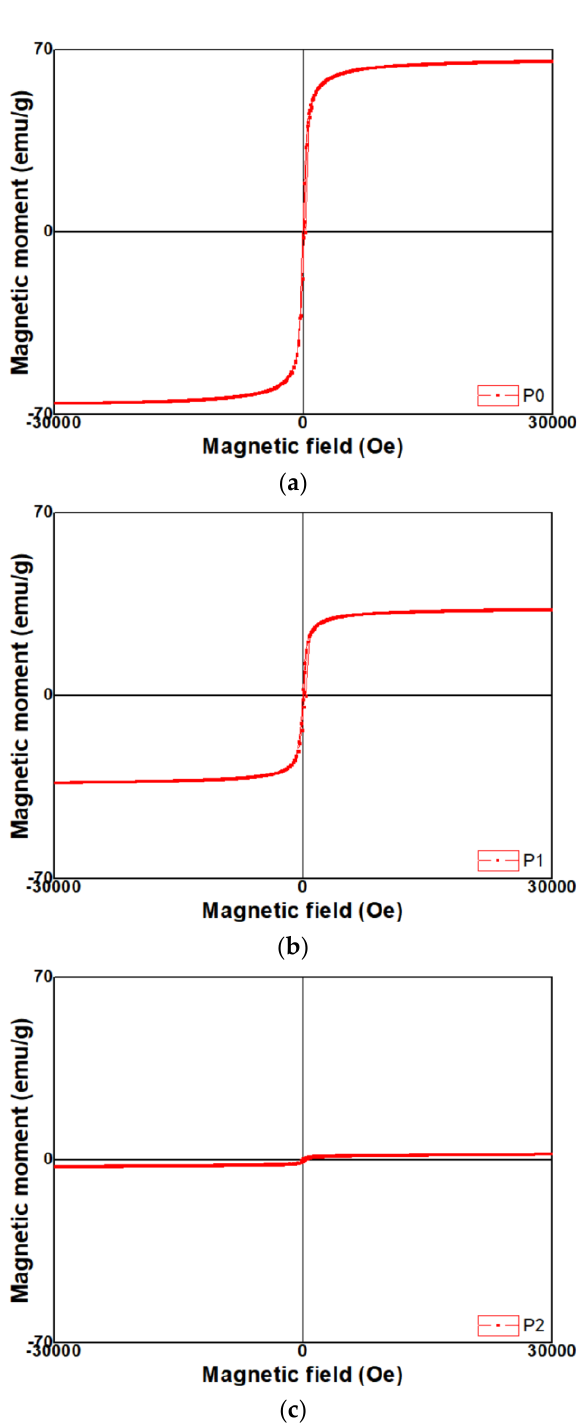
Figure 7. Magnetic properties of FeO x NPs with ( a ) 0 wt%; ( b ) 1 wt%; ( c ) 2 wt% PVP.